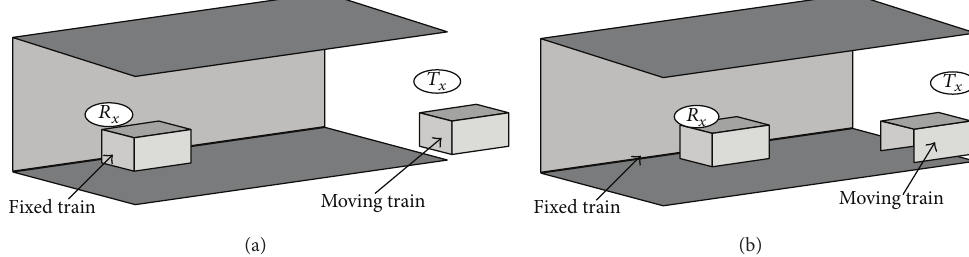
Figure 4: Modelling of propagation environment: (a) the full model, (b) the simplified model.